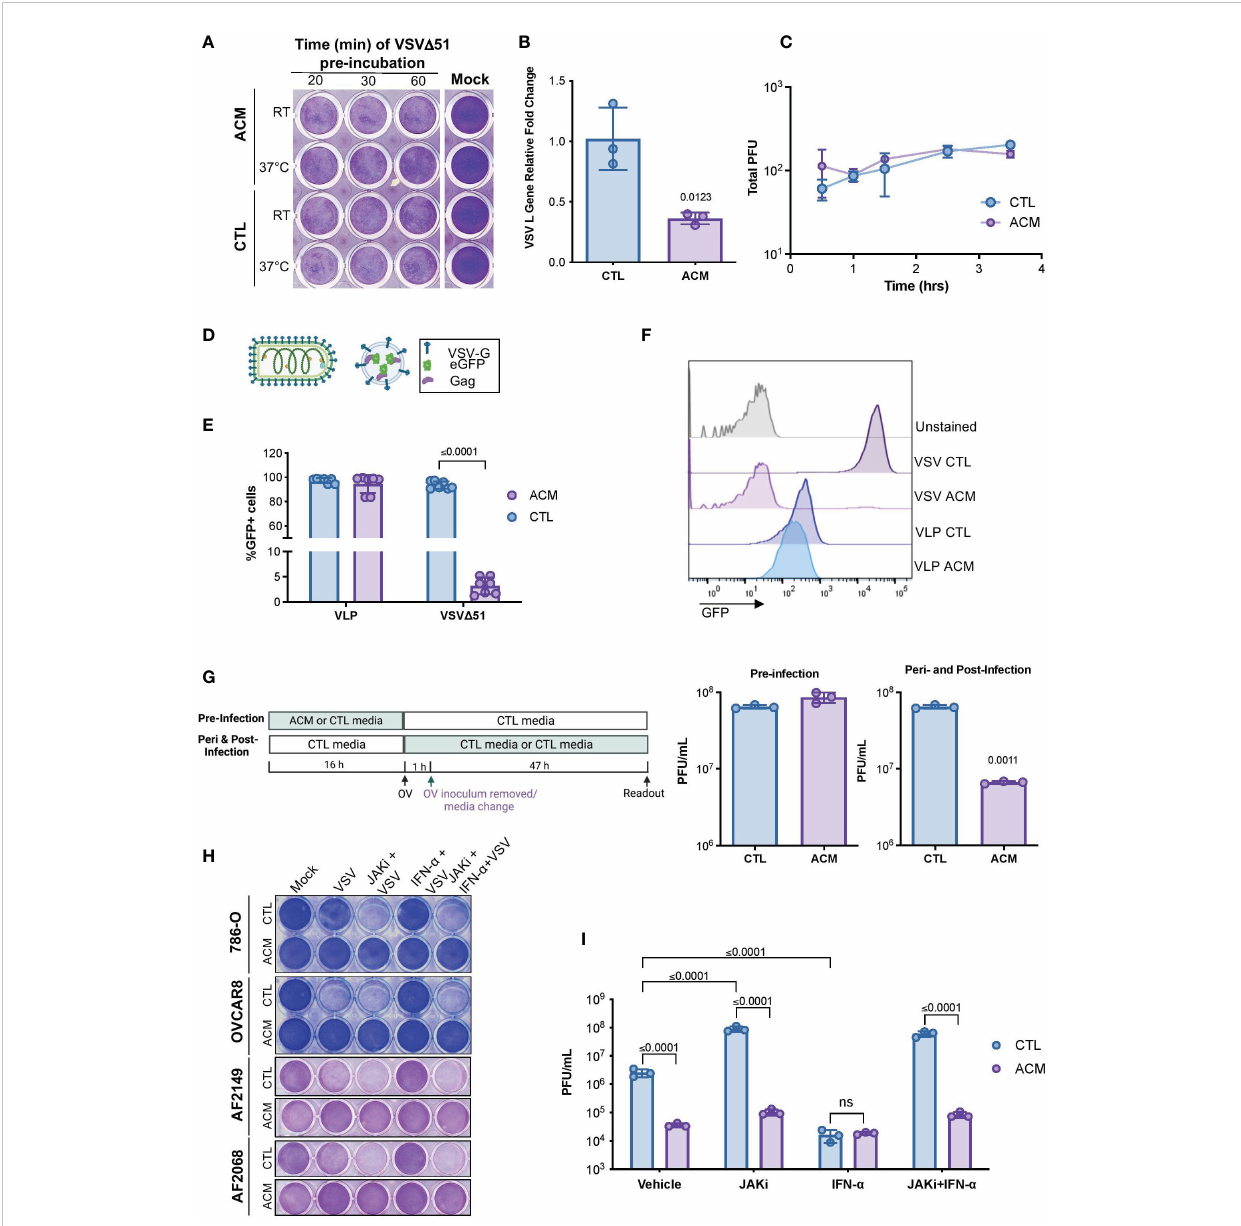
FIGURE 2 ACM-mediated OV resistance occurs post-virus entry and is a Type I IFN-independent phenomenon. (A) Cytotoxicity induced by VSV D 51 inoculums (MOI 1, 48hpi) that were pre-incubated in CTL medium or ACM at room temperature (RT) or 37°C for the indicated lengths of times and then used to infect OVCAR8 cells in CTL medium. (B) OVCAR8 cells in CTL medium were infected with MG1 D G (MOI 3). After 1 hour, the virus inoculum was removed and changed to CTL medium or ACM. The RNA was extracted at 24 hpi, and the expression of VSV gene L was evaluated by qPCR relative to cellular Rplp0 loading control. Data indicate the mean ± SEM of three biological replicates. Two-tailed, unpaired t-test. (C) Cells were incubated in CTL medium or ACM for the indicated amount of time prior to infection with VSV D 51 (150 infectious particles). Following 1 hour of infection, the virus inoculum was removed and replaced with a semi-solid overlay. After 48, viral titers (in PFU) were quanti fi ed and plotted. Lines connect means. Two-way ANOVA, Sidak ’ s multiple comparison test. (D) Cartoon comparing a VSV-eGFP virion and a GFP-loaded VLP pseudotyped with VSV-G. (E,F) CTL medium or ACM-receiving cells were infected with GFP-expressing VSV D 51 (MOI 0.1) or transduced with GFP-loaded VLPs pseudotyped with VSV-G for 24 hours and percentage of GFP positive cells was assessed by fl ow cytometry. Data indicate the mean ± SEM (n=7). Two-tailed, unpaired t-test for VLP or VSV D 51-infected samples. (G) As summarized in the displayed experimental timeline, OVCAR8 cells were cultured overnight in CTL medium or ACM, and the medium was changed to CTL medium at the time of VSV D 51 infection. Alternatively, the medium was changed to a CTL medium or ACM at the time of infection. The virus inoculum-containing medium was removed following an hour of infection and replaced with the same medium at the time of infection. Viral titers were quanti fi ed by plaque assay. Data indicate the mean ± SEM of 3 biological replicates. Two-tailed, unpaired t-test for each CTL vs ACM pair. (H, I) Cell lines or patient ascites cells were cultured in CTL medium or ACM overnight and treated with JAK I inhibitor (1 m M), IFN- a (200 U/mL), or both prior to infection with VSV D 51 (MOI 1) for 48 hours. Cytotoxicity assay was performed to evaluate virus-mediated cell death (H) , and the supernatant was collected for quanti fi cation of infectious particles by plaque assay (I) . Data indicate the mean ± SEM of 3 biological replicates. Two-way ANOVA, Tukey ’ s multiple comparison test on log 10 transformed